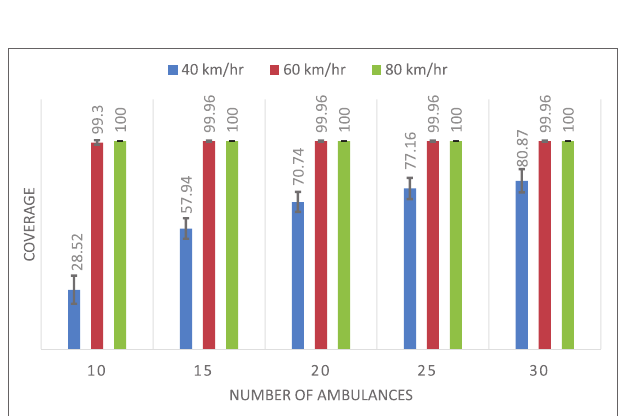
FigUre 9 | Mean and SD of the coverage using double standard model with fuzzy inference system.